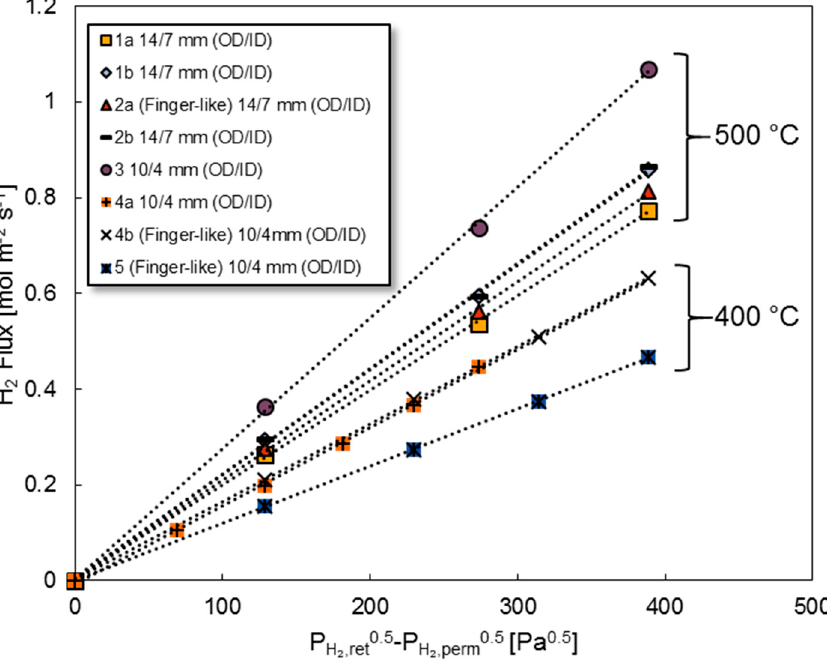
Figure 4. Initial hydrogen permeance of the membranes as measured after air activation.